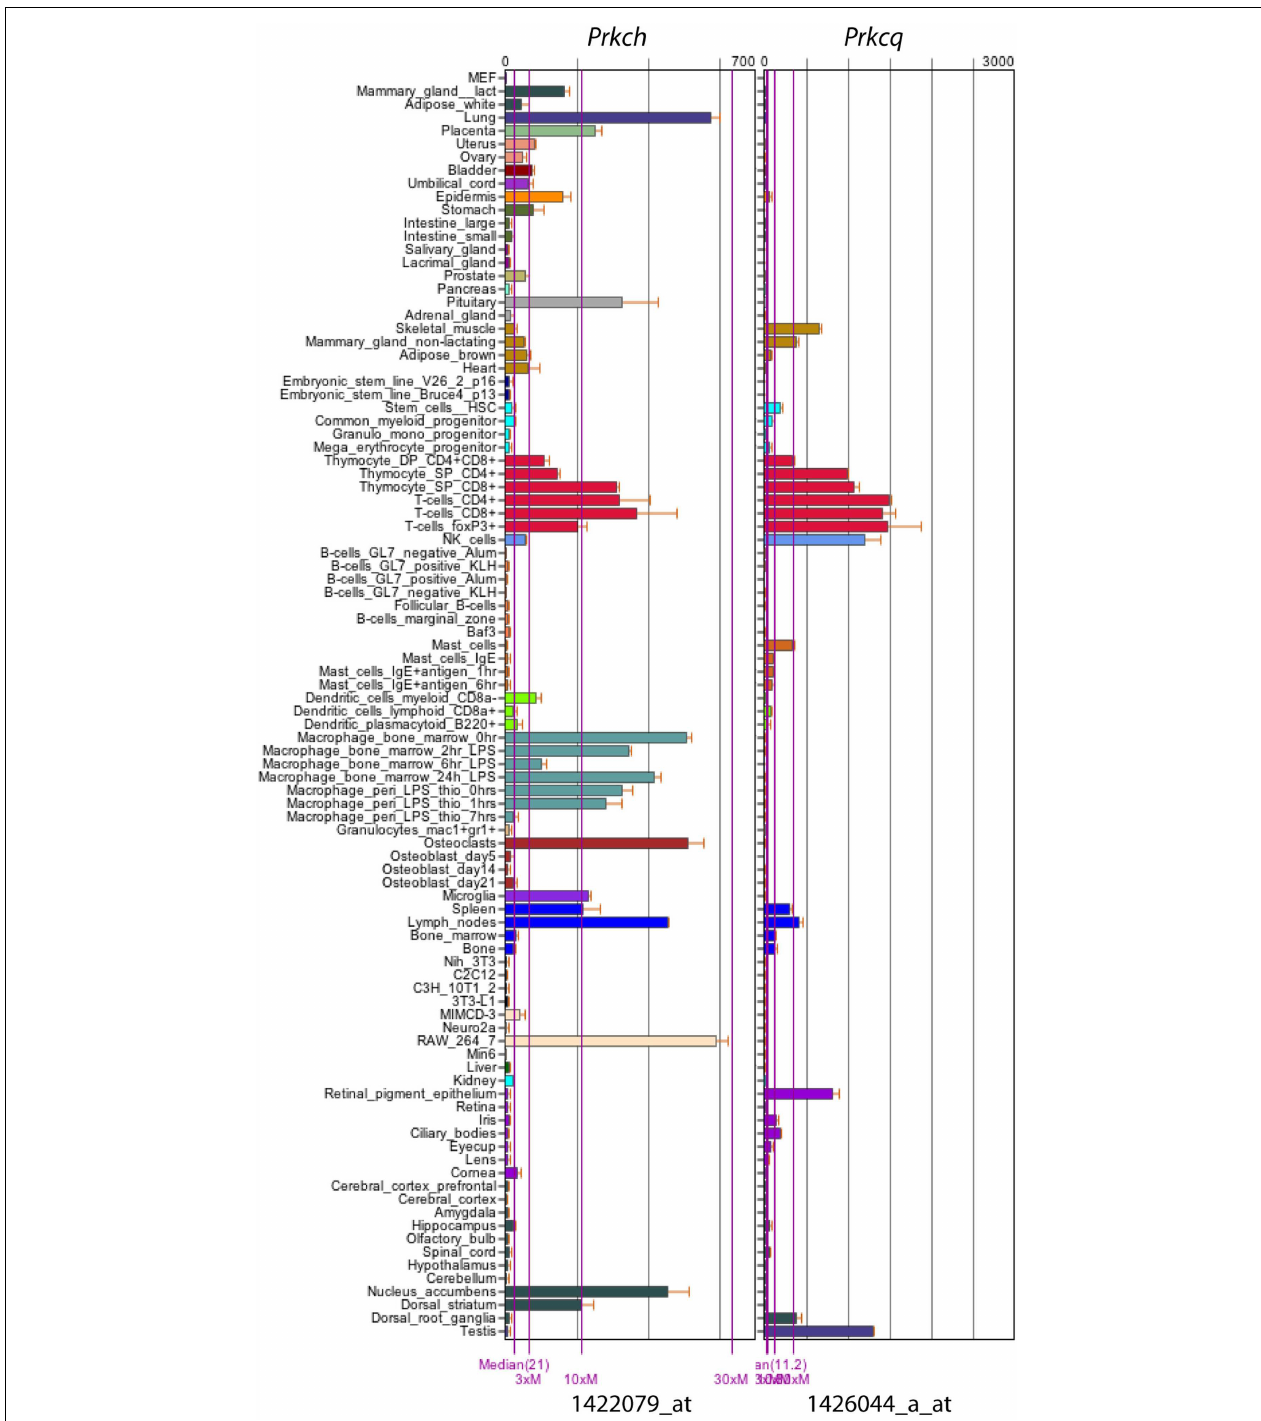
FIGURE 1 | mRNA expression profile of mouse PKC η ( Prkch ) and PKC θ ( Prkcq ). Data were obtained from www.biogps.org using GeneAtlas MOE430, gcrma (Su et al., 2004;Wu et al., 2009), with probes 1422079_at ( Prkch ) and 1426044_a_at ( Prkcq